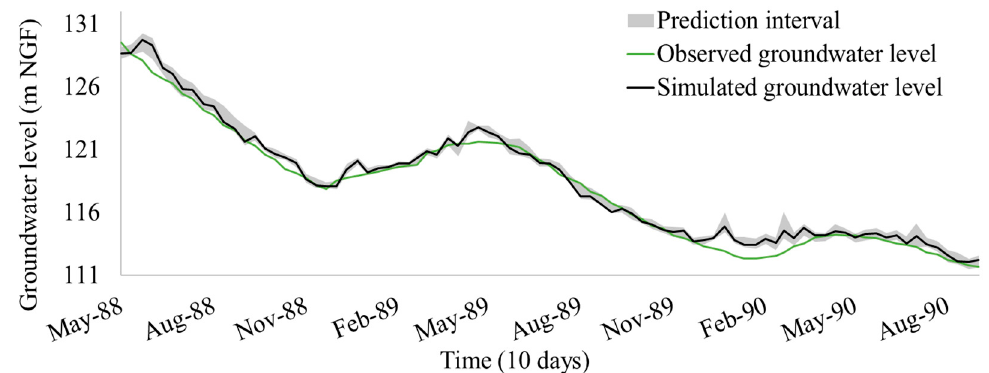
Figure 12. Groundwater level forecasting with 20 days’ lead-time. Grey band shows the variability due to the parameter’s initialization and to the rain spatial variability. C p = 0.40; C PICP = 0.49; C MPI = 0.73 m.